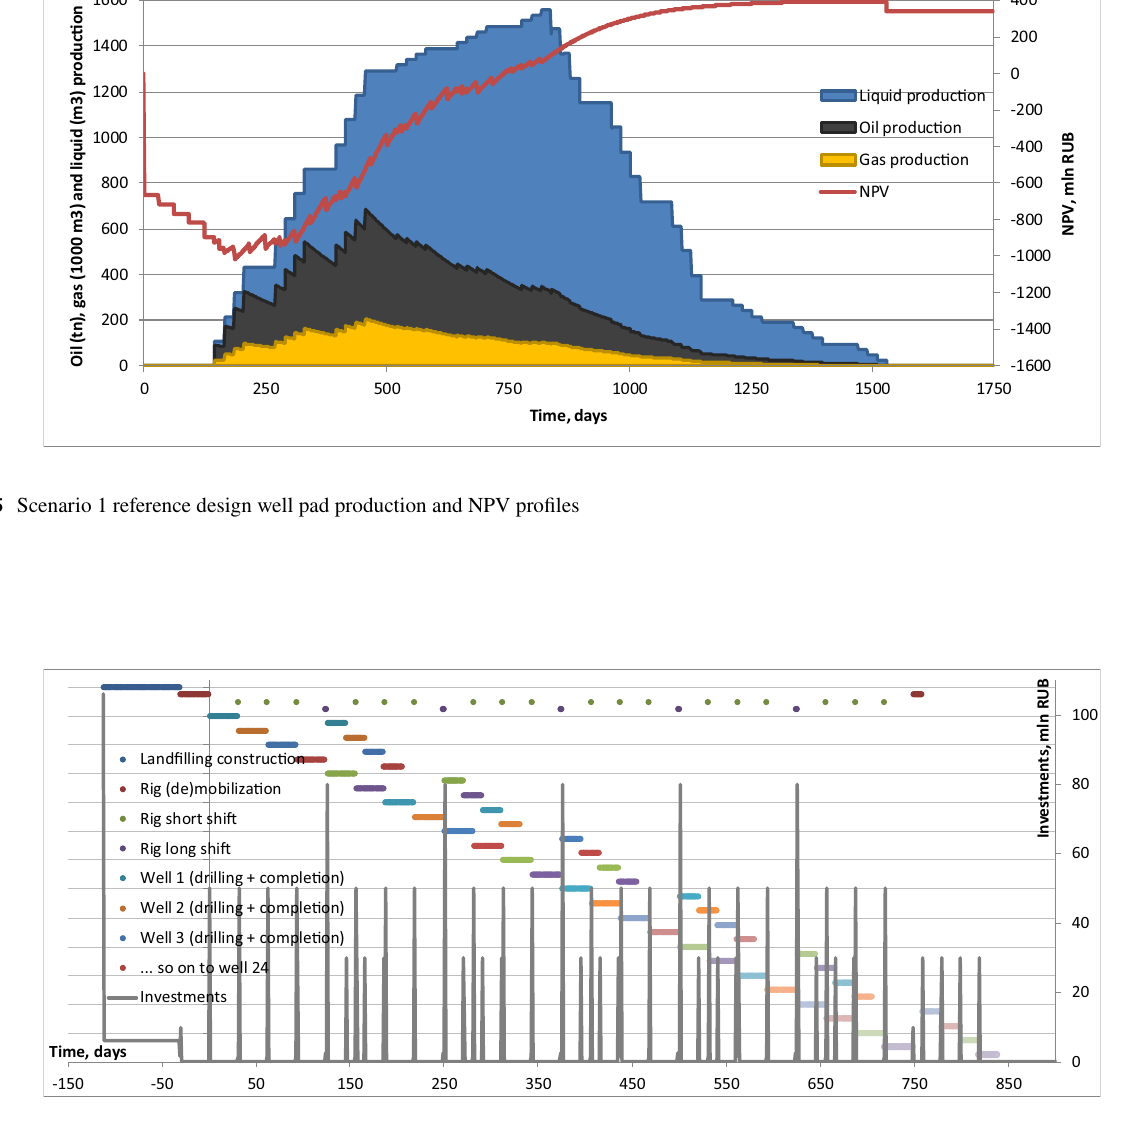
Fig. 6 Scenario 2 reference design well pad construction, drilling and completion schedule with corresponding investments (for clarification, see caption of Fig.